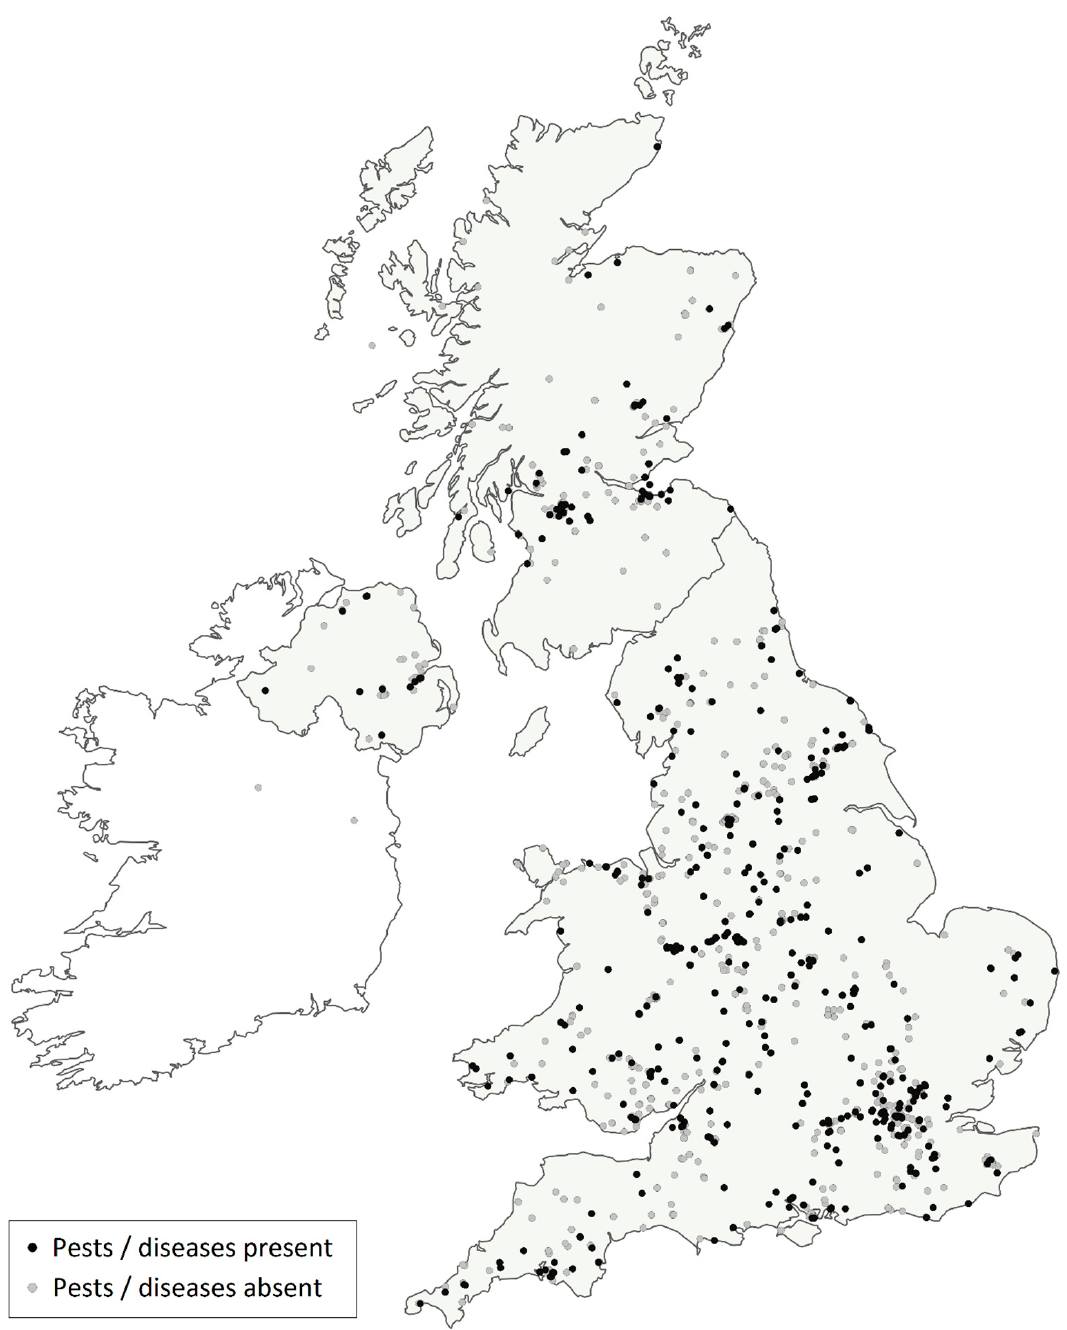
Figure 1. Map of completed surveys and “positive” P&D records.